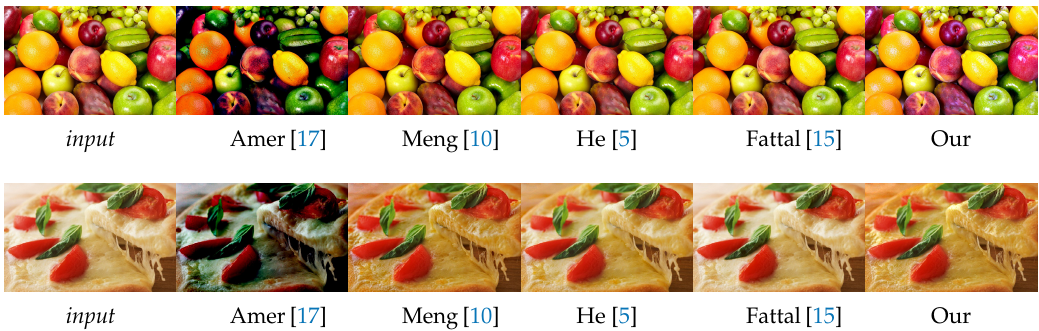
Figure 11. Qualitative results on haze-free images. Red boxes indicate dehazing artifacts.